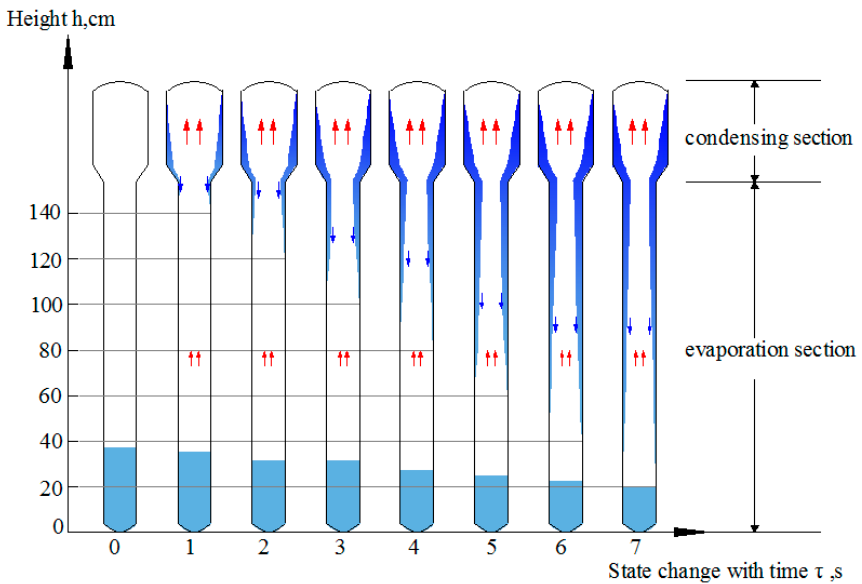
Figure 6. Diagram of the working state change during the start-up process of a solar gravity heat pipe.